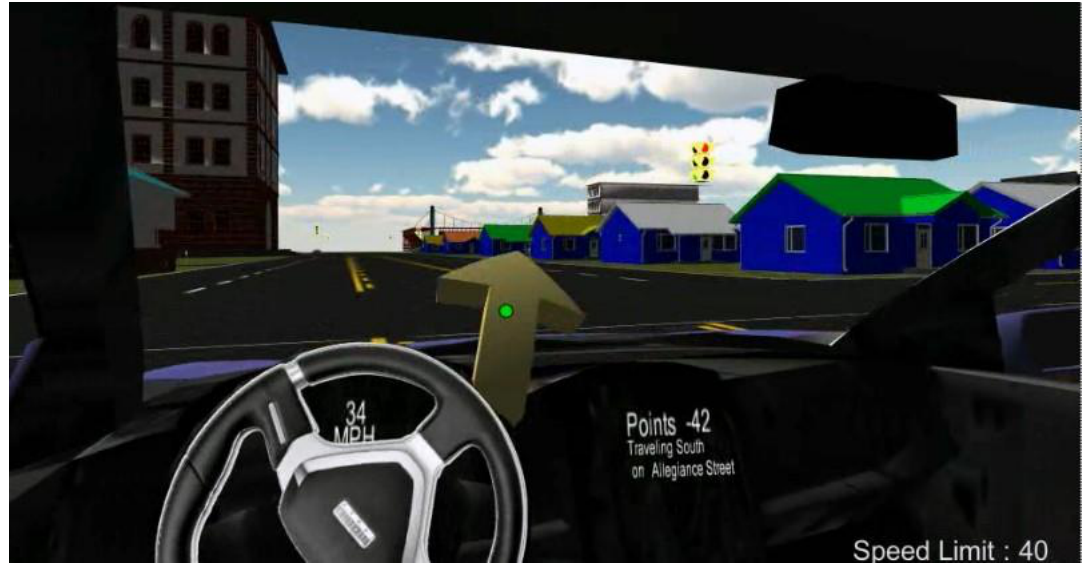
Figure 1. The first-person view of a player vehicle (PV) and game-based, multi-player, online simulated training (GMOST).